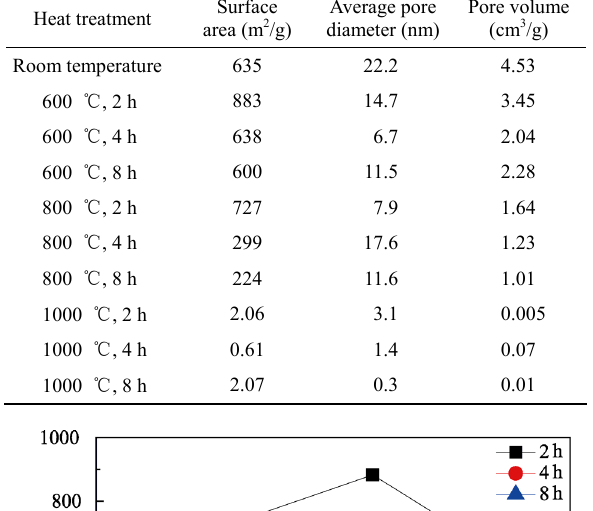
SiO 2 aerogels before and after thermal treatment at